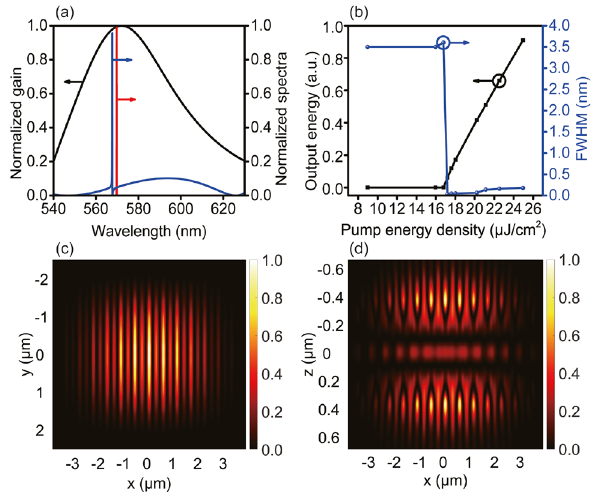
Figure 4: Lasing characterization results. (a) Gain spectrum of R6G (black curve), cavity mode spectrum (blue curve), and typical emission spectrum of laser (red curve) operated above threshold; (b) input–output function curve (black) and spectrum linewidth changing as a function of input energy (blue); (c) near field intensity distribution of laser in ( x , y ) plane at z = 612 . 5 nm; (d) electric field intensity distribution in ( x , z ) plane at y = 0